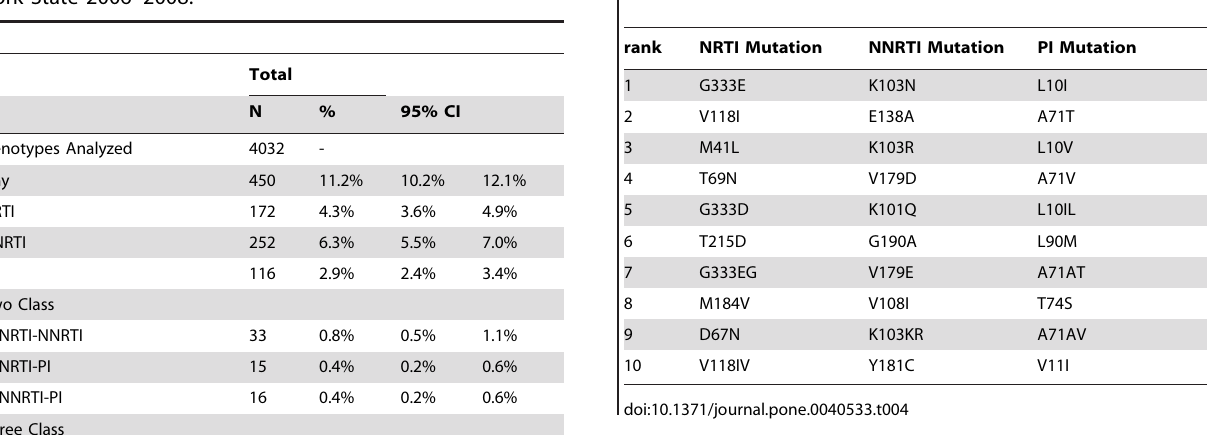
Table 4. Top 10 mutations by drug